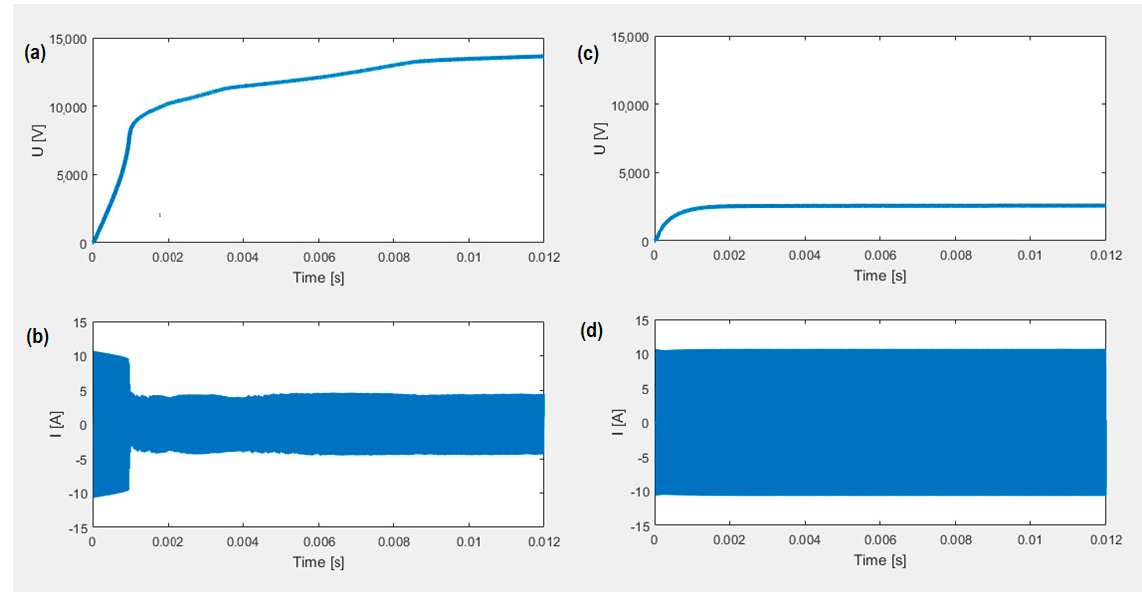
Figure 5. Peak voltage on the charged output capacitor ( a ) and instantaneous value primary winding current of the transformer ( b ) in a model with parasitic capacitance and voltage on the charged output capacitor ( c ) and instantaneous value current in the primary winding of the transformer ( d ) in a system with a transformer with parasitic capacitance (simulation results).